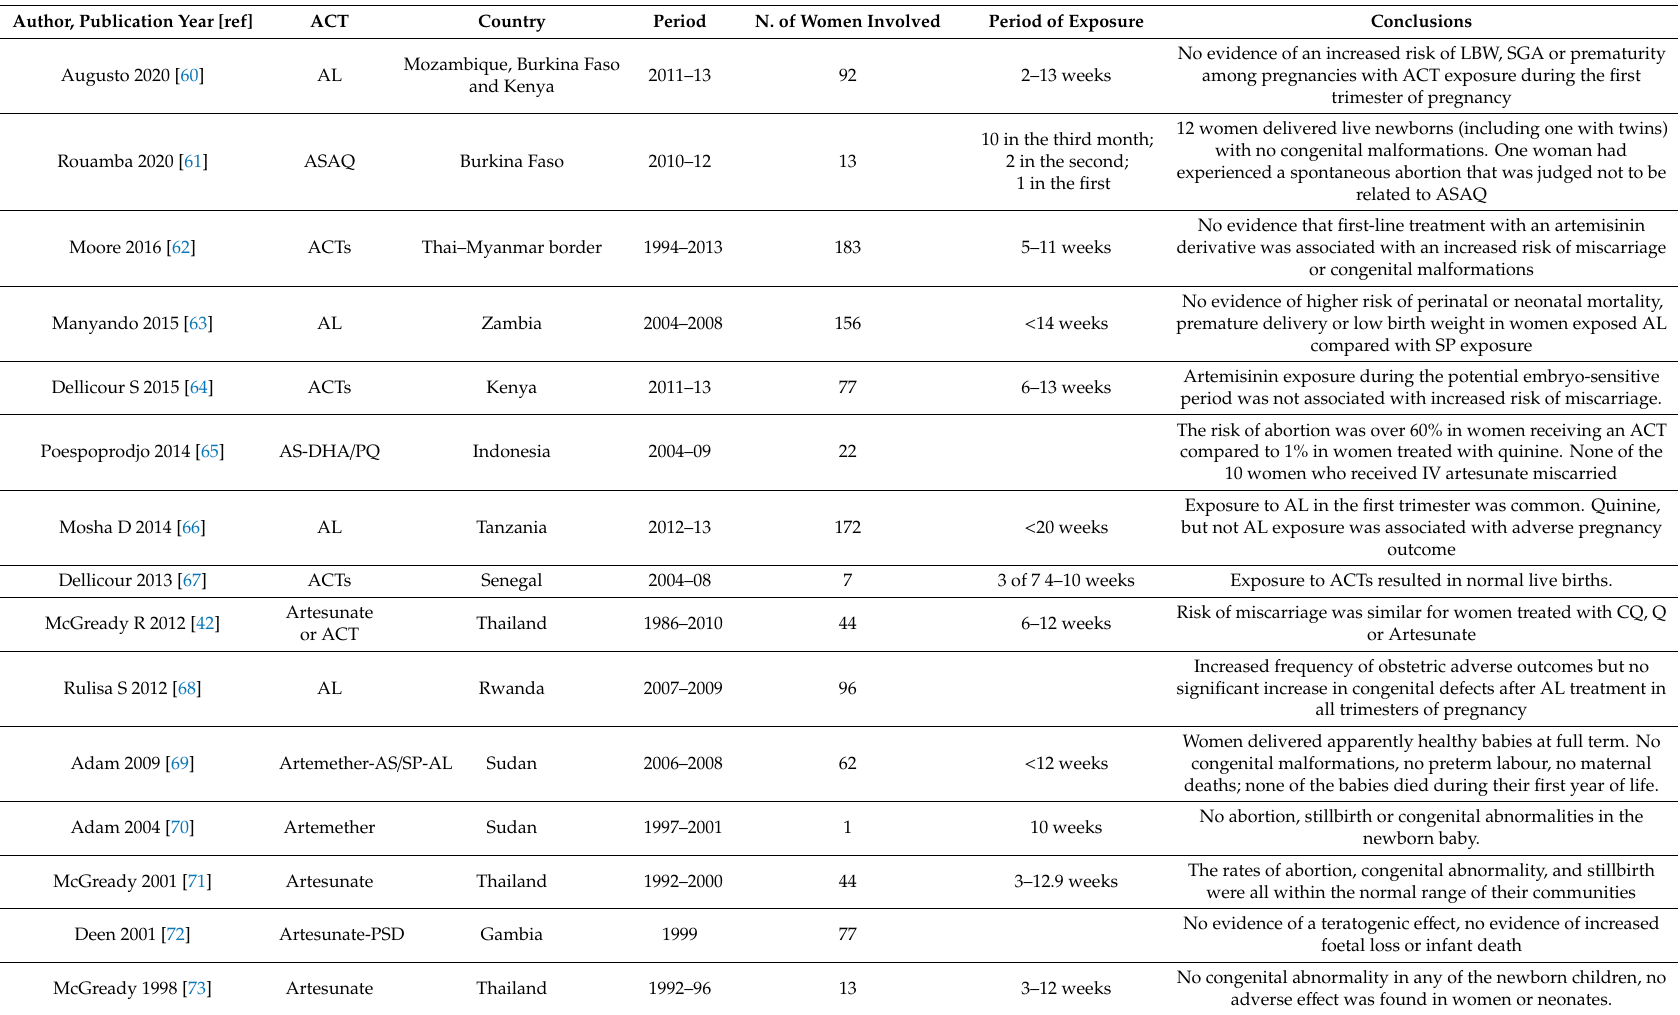
Table 2. Observational studies on the use of artemisinin derivatives in the first trimester of